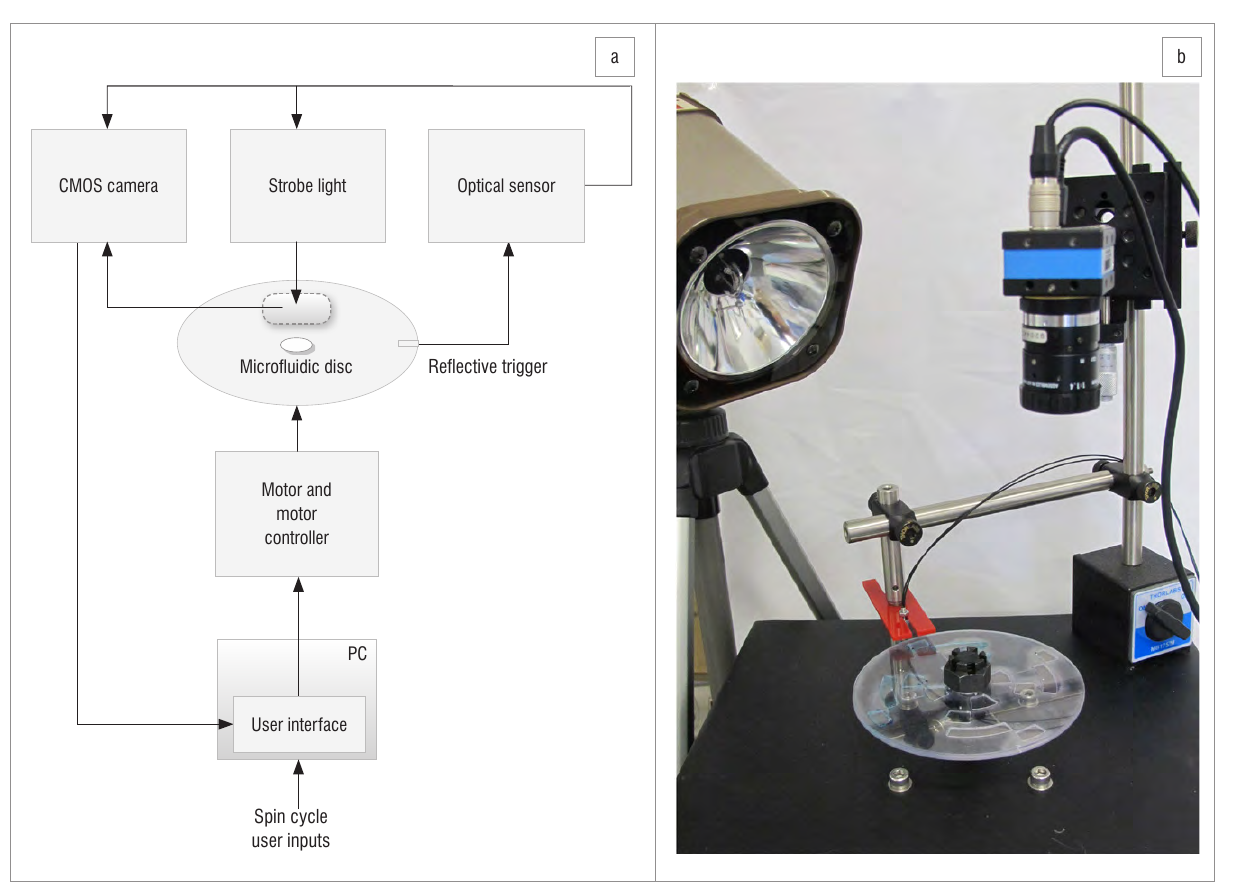
Figure 2: (a) Schematic of the components required for fluidic control and imaging of the disc device and (b) the integrated testing system